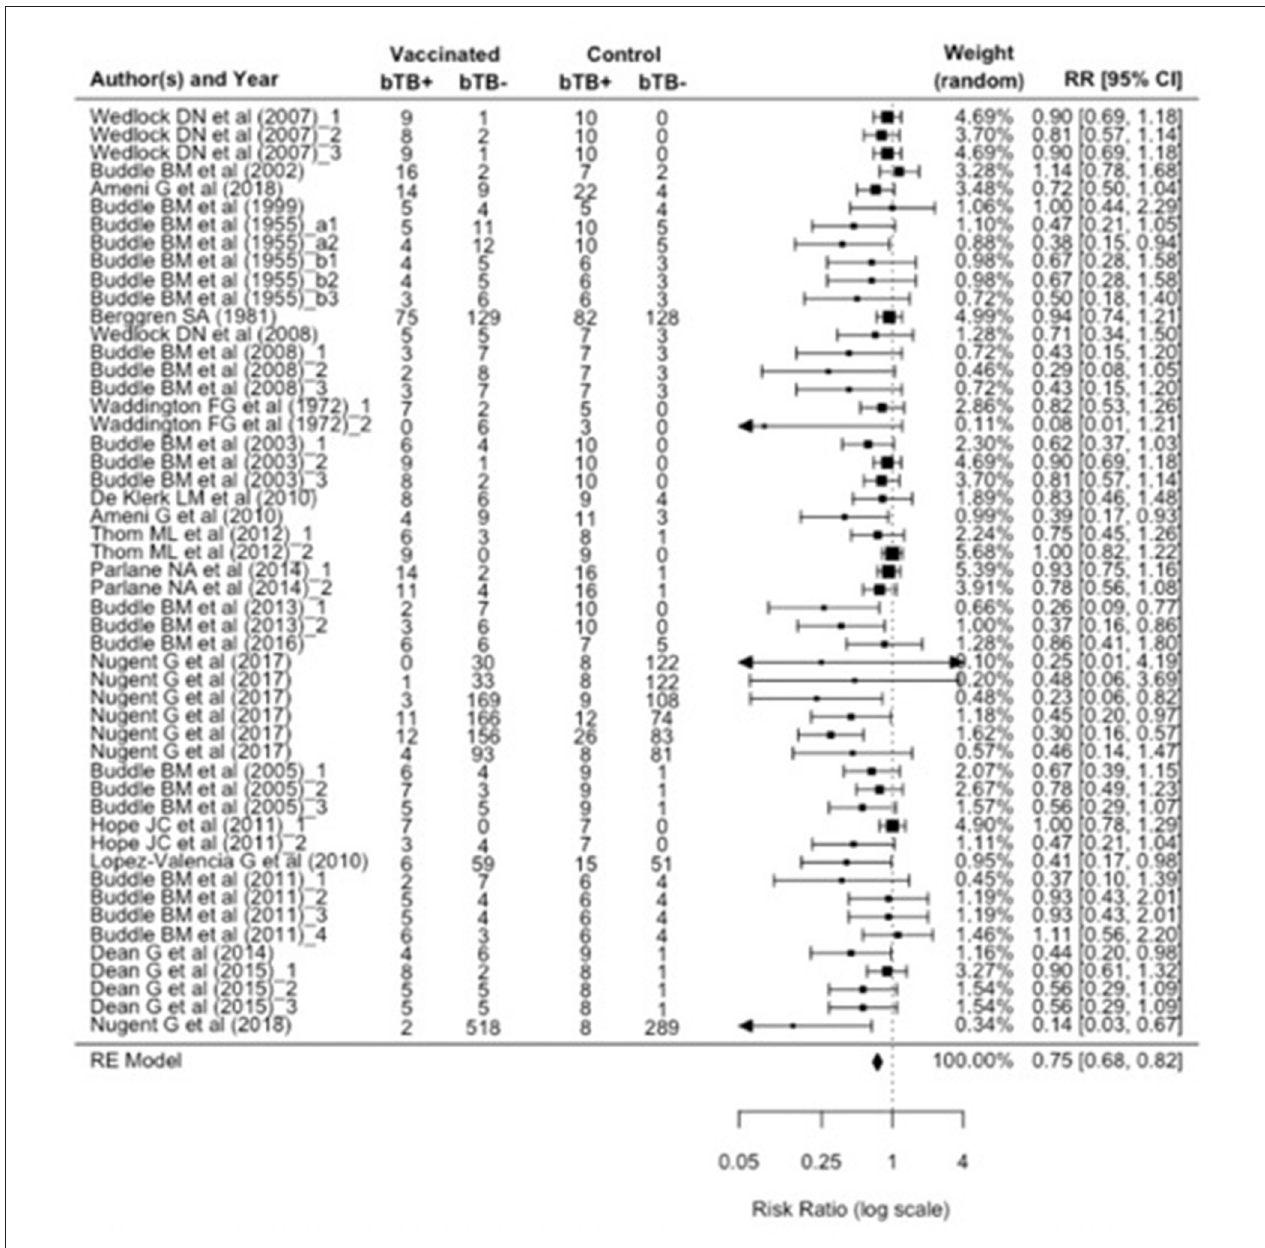
FIGURE 3 | Forest plot visualizing the relative risk ratio calculated for each included publication in the meta-analysis. The weight given to each included publication per the RE model is shown. “bTB + ” refers to the number of animals reported to have infection and/or pathology (per culture and/or postmortem examination). And “bTB-” refers to the number of animals not reported to have infection and/or